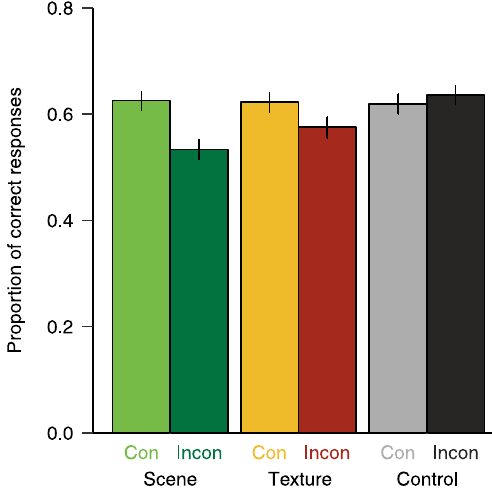
Figure 4. Proportion of correctly named consistent (Con) and inconsistent (Incon) objects which were superimposed on scenes, textures, and colour controls. Error bars depict the standard error of the